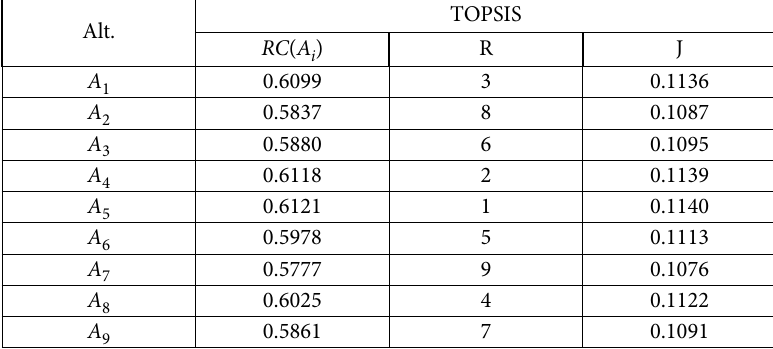
Table 5. Rankings of gerontechnologies using the method described in Subsection 3.4 Alt.